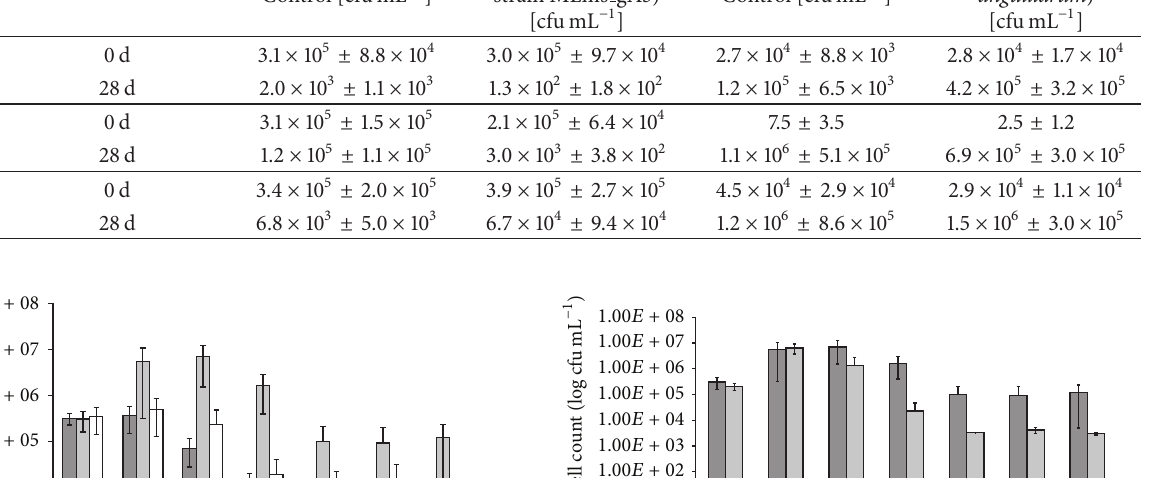
Table 2: Viable cell counts (as colony forming units, cfumL −1 on agar plates) of Vibrio anguillarum and Pseudoalteromonas sp. strain MLms gA3 in the control, as well as in the treatments with added P . sp. strain MLms gA3 and V. anguillarum . V. anguillarum Treatment (+ P . sp.